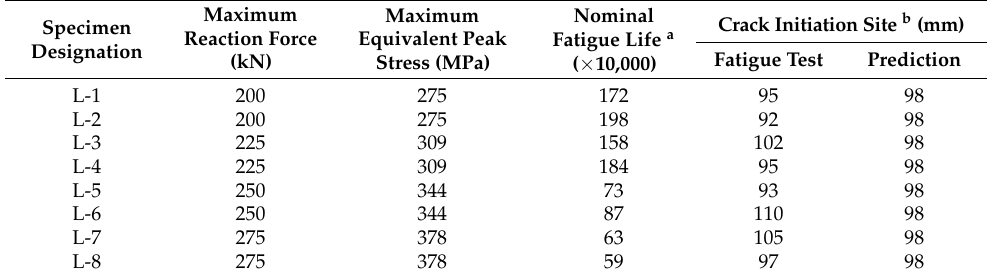
Figure 11. Dimensions of the variable-section support specimens with right-angle curved end plates. Every test specimen was simply supported by a roller and rocker system. A spreader beam was used to realize two-point loading. The loading points were 700 mm from the end of the beam. A loading frequency of 4–5 Hz was used to conduct fatigue tests. For each specimen, the ratio of reaction force between minimum and maximum was 0.1. The loading and test results are shown in Table 3. Table 3. Fatigue test results of the variable-section supports with right-angle curved end plates.